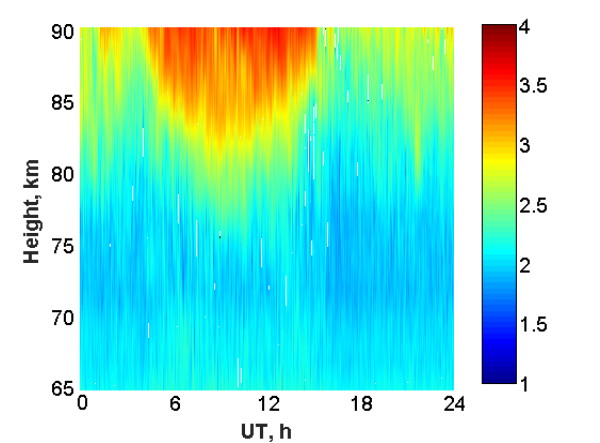
Fig. 6. The averaged electron density of experimental data (lg[ N e ], cm -3 ) on March 13, 14, 16-20, 24-26, 2017. The ten-days averaged electron density profiles Ne ( h ) were constructed from the model and observations data at the four moments: 02:00 UT, 10:00 UT, 12:00 UT, and 22:00 UT and are shown in Fig. 7 (red lines correspond to the calculations by model (PGI) and blue lines correspond to the profiles calculated from